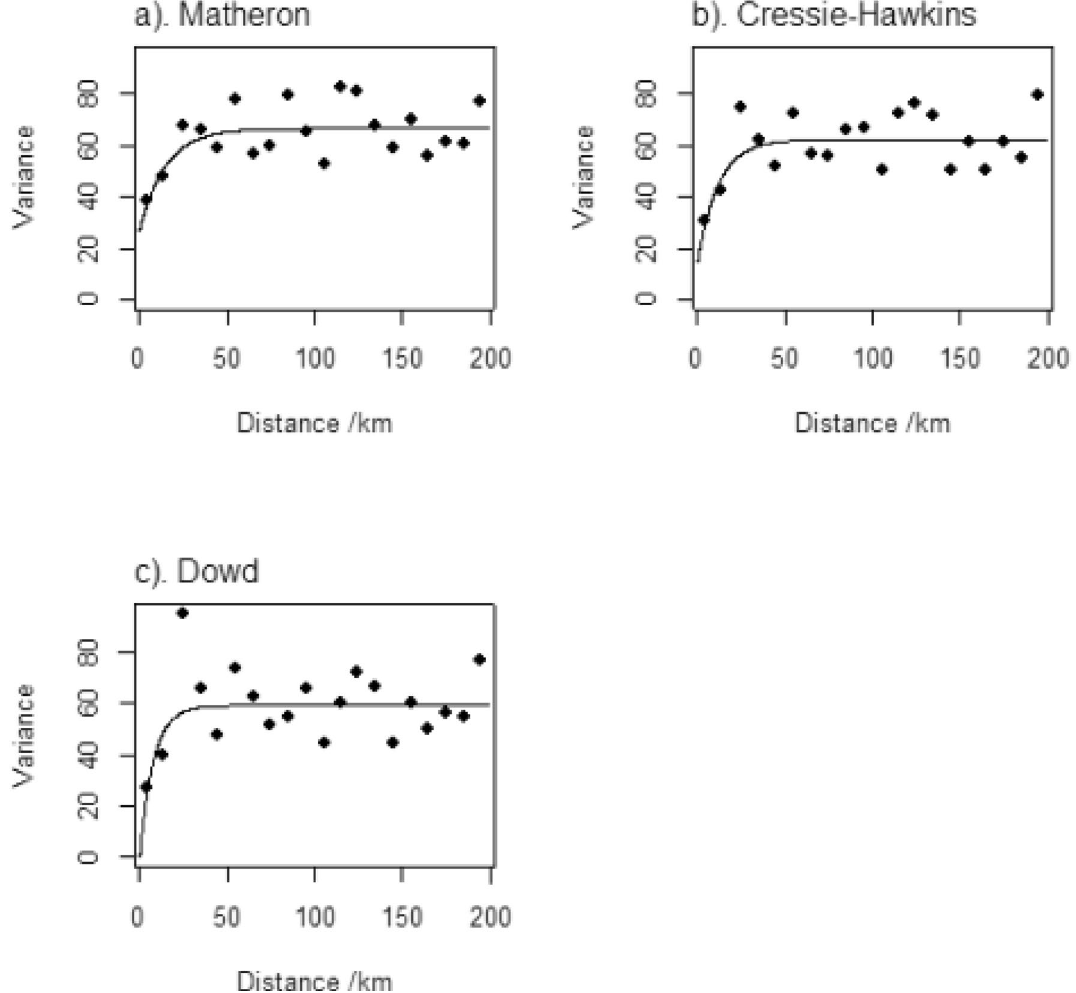
Figure 1. Variograms of WRA serum Zn estimated by different estimators; ( a ) Matheron estimator, ( b ) Cressie–Hawkins estimator and ( c ) Dowd